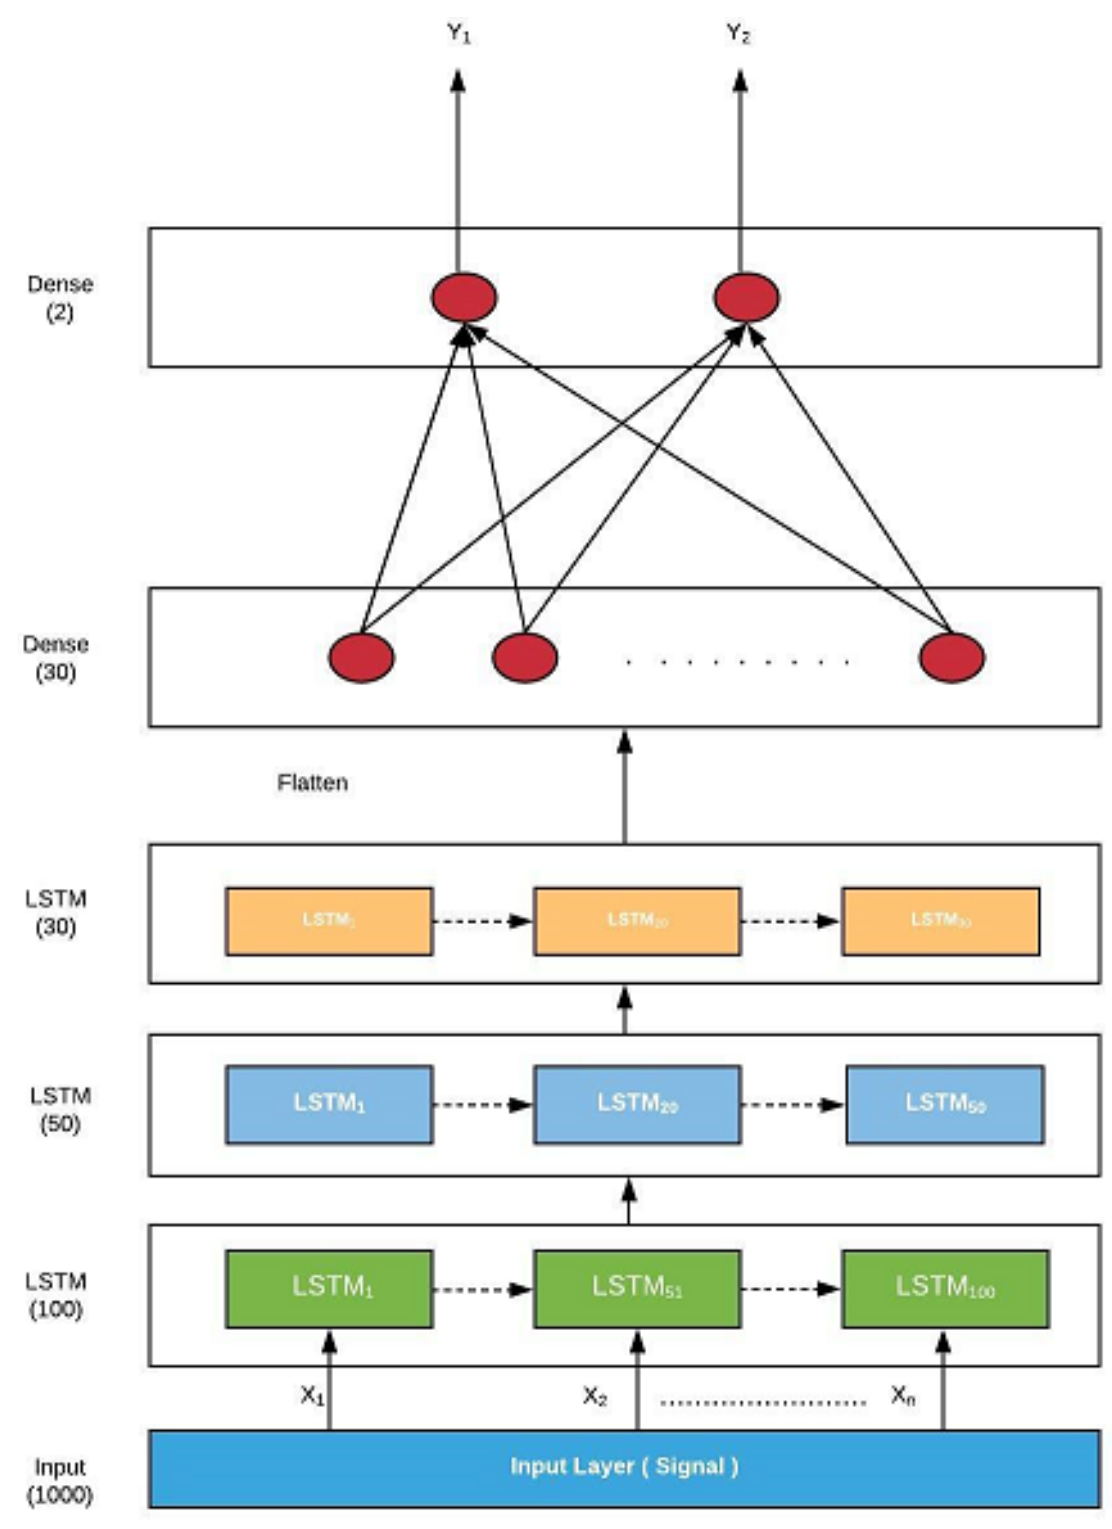
Figure 3: Proposed LSTM based model for classification of gearbox health